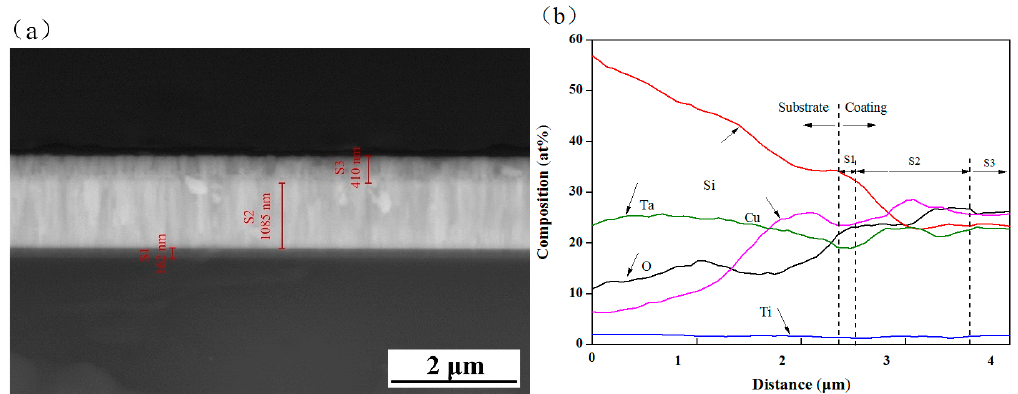
Figure 6. ( a ) Cross-section SEM image and ( b ) EDS line scan results along the thickness of C3 coating on the Si substrate.